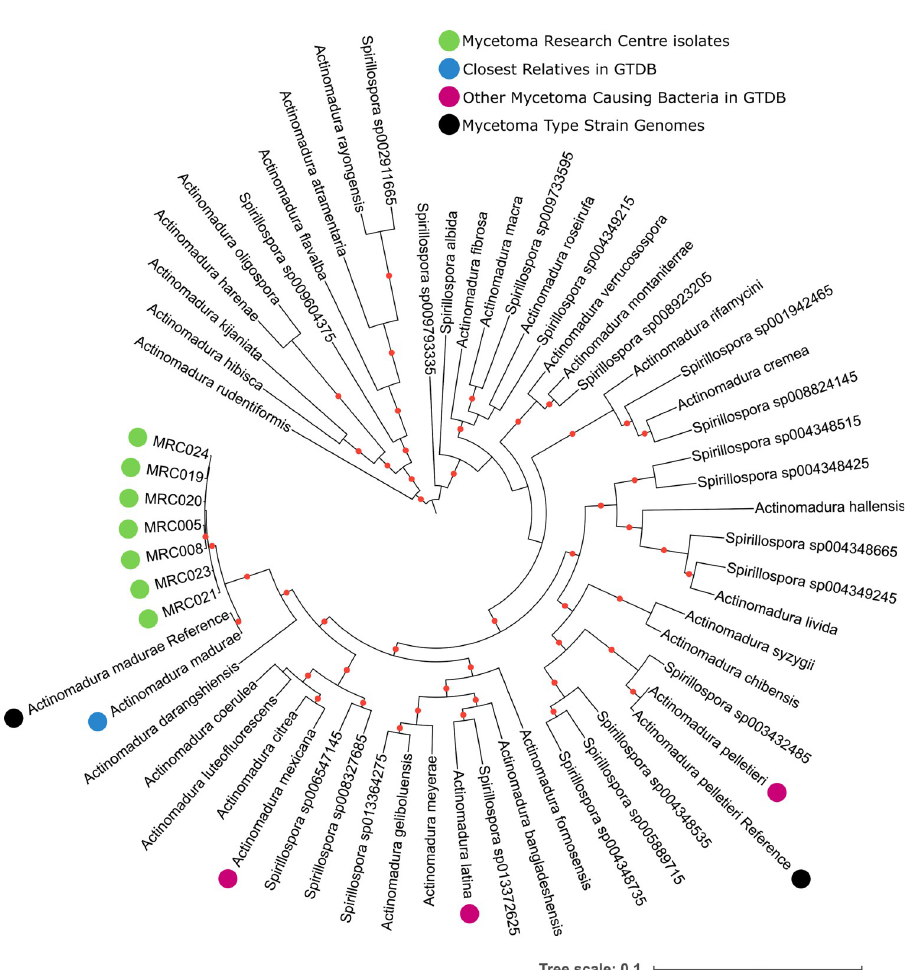
Fig 5. Tree of single copy orthologs that belong to the GTDB bac120 dataset from the genomes of Actinomadura related isolates from the Mycetoma Research Centre (green), their relatives according to ANI in GTDB (with the closest relatives indicated in blue) and genomes from type strains of species typically associated with actinomycetoma (black). Additionally, the type strain genome of any organism previously isolated from mycetoma patients and present in the GTDB is highlighted (pink). A red dot on branches indicates ultrafast bootstrap support > 95. The tree was inferred in iqtree2 using the C20 model.